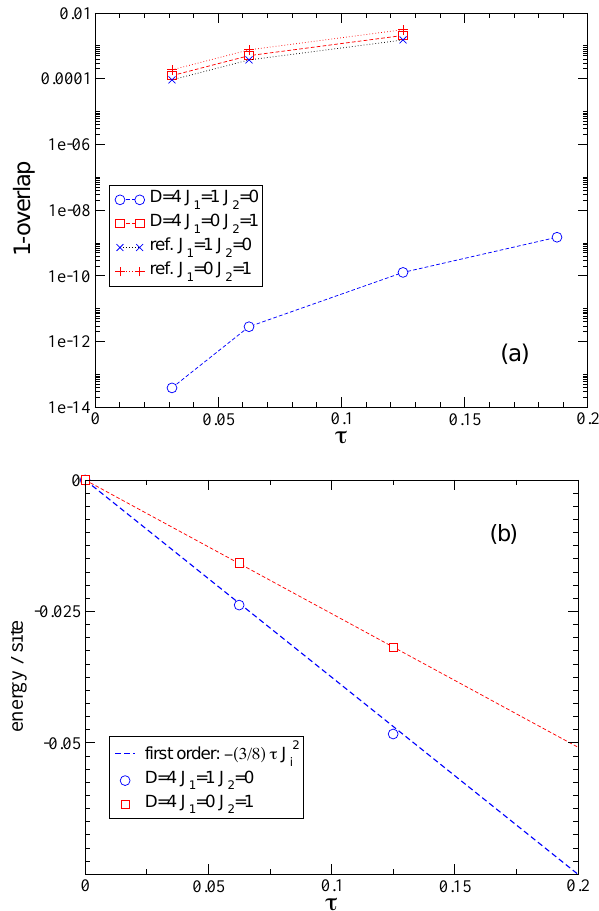
Figure 9: (a) Deviation of the maximized fidelity O for the first τ -step at β = 0 computed on a 2 × 2 isolated plaquette. References (see text) are shown as × and + . (b) Energy per site obtained from the optimized site tensor on an isolated 2 × 2